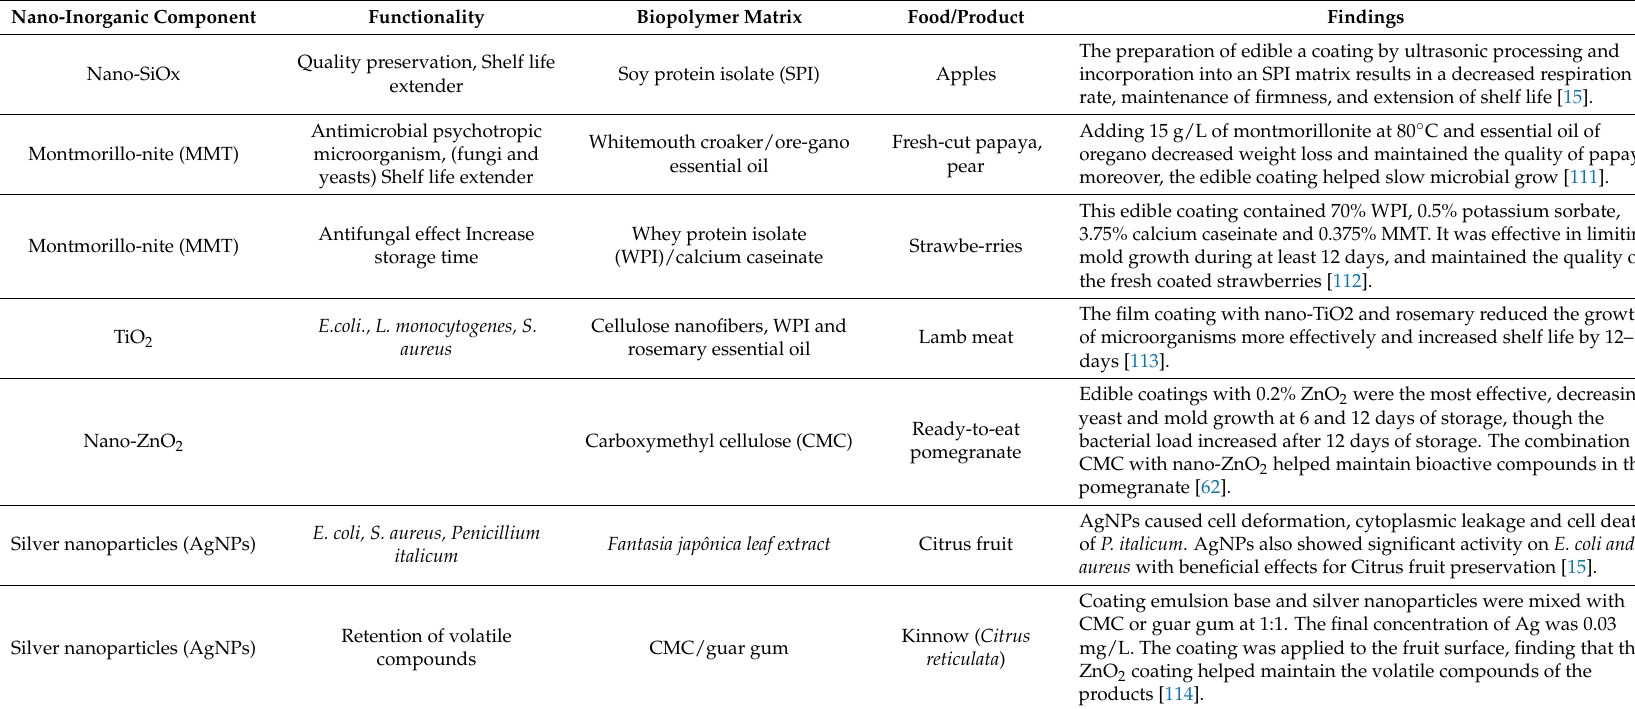
Table 4. Nanocomposites in edible coatings to improve the mechanical properties and/or antioxidant and antimicrobial